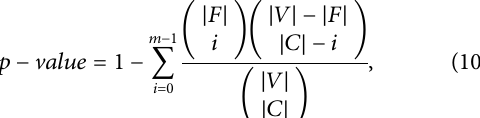
TABLE 8 | Protein complexes with lower p -value identi fi ed by the algorithm on the